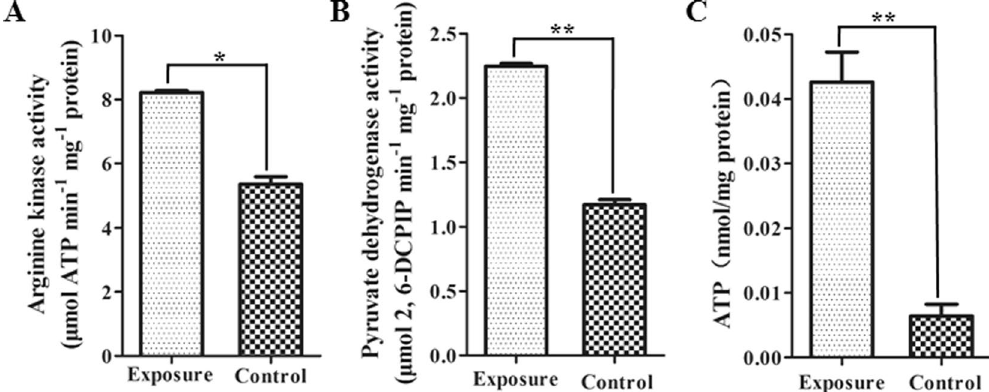
Figure 3. Effects of Cry6Aa2 toxin on the energy metabolism in C . elegans . ( A ) Effect of Cry6Aa2 toxin on the activity of arginine kinase; ( B ) effect of Cry6Aa2 toxin on the activity of pyruvate dehydrogenase E1; ( C ) effect of Cry6Aa2 toxin on the total cellular ATP. Data are shown as the mean ± SD. A single asterisk indicates P < 0.05, two asterisks indicate P <